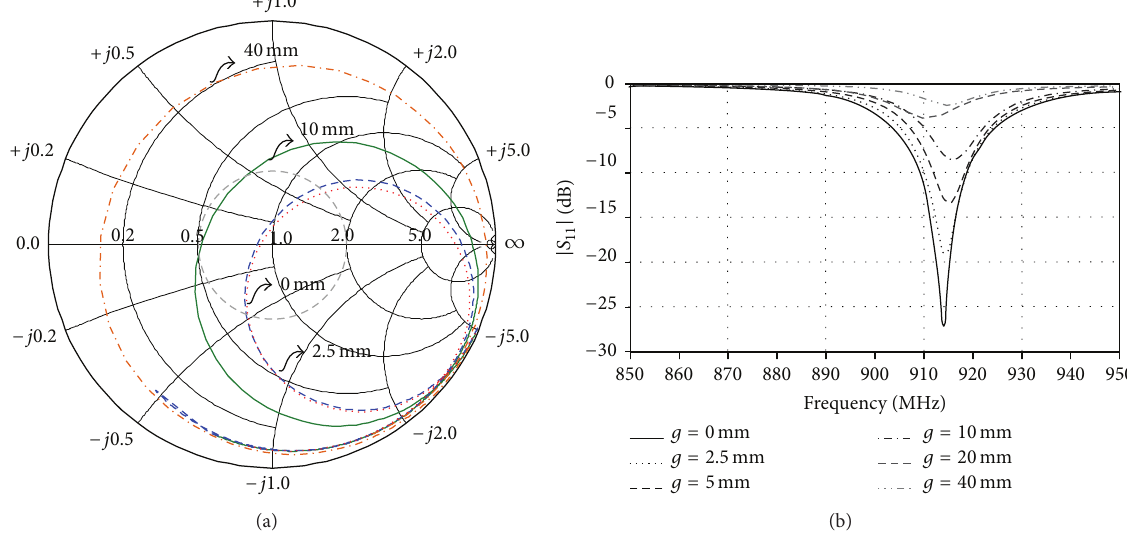
Figure 12: Simulated (a) input impedance characteristics and (b) |𝑆 11 | characteristics as a function of 𝑔 .